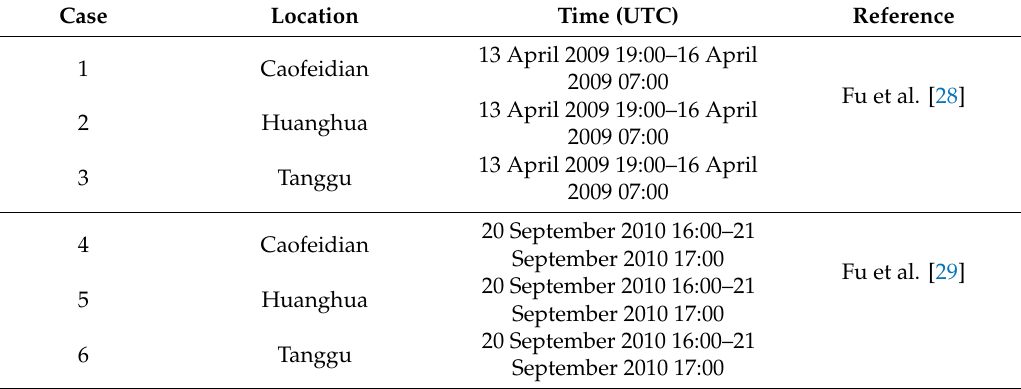
Table 2. Meteorological